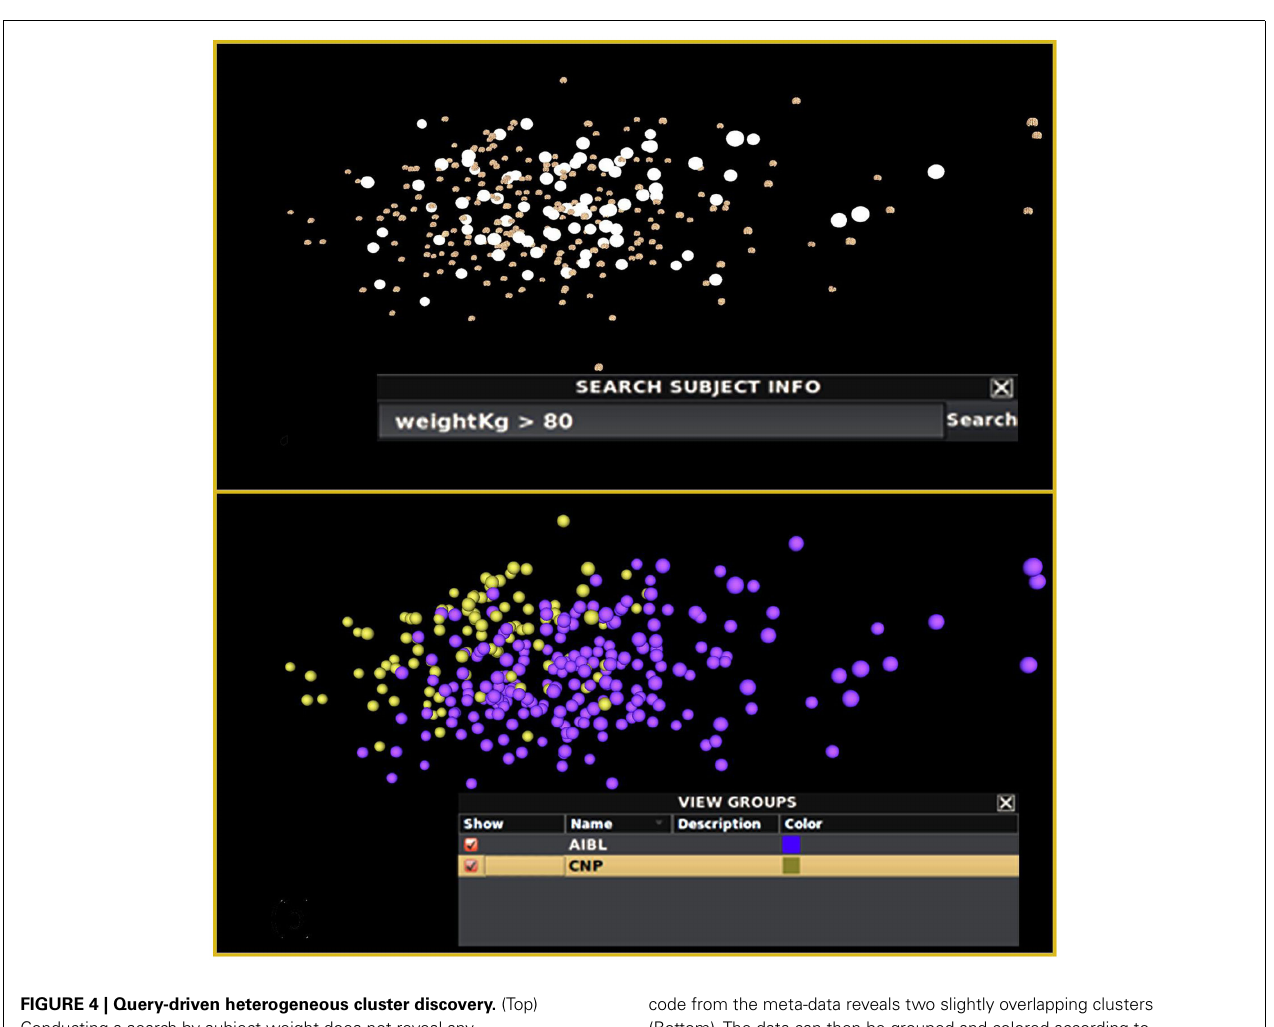
FIGURE 4 | Query-driven heterogeneous cluster discovery. (Top) Conducting a search by subject weight does not reveal any particularly interesting clustering of the brain surfaces within INVIZIAN. Alternatively, querying by the imaging study identifier